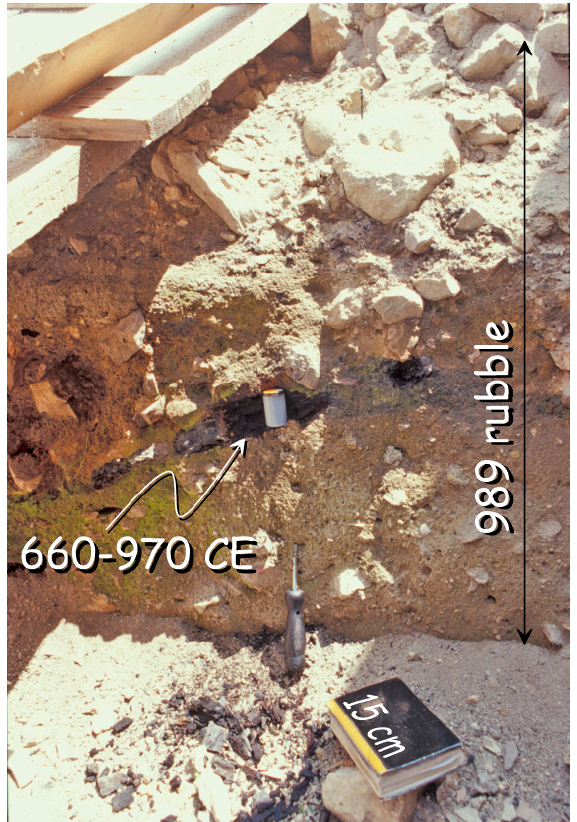
Figure 7. Rubble and abandonment layers excavated in the Forum area of Compsa, over the limestone slabs (below the booklet). The radiocarbon dating of a charred wood (660–970 CE; 2 σ cal. age) provided the post quem term for the destruction of the Early Middle Age town in the 989 earthquake (photo by P.G.).